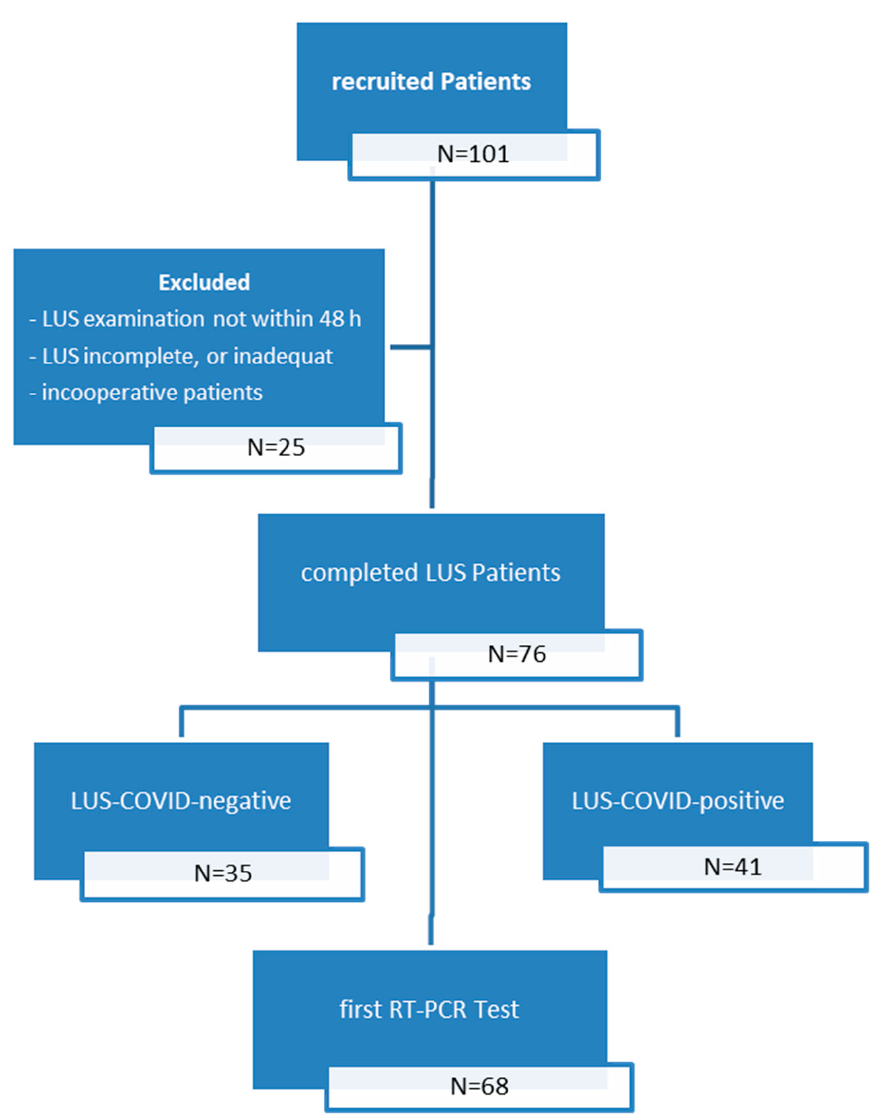
Figure 1. Flow chart of the patient selection and classification according to the lung ultrasound and reference standard.